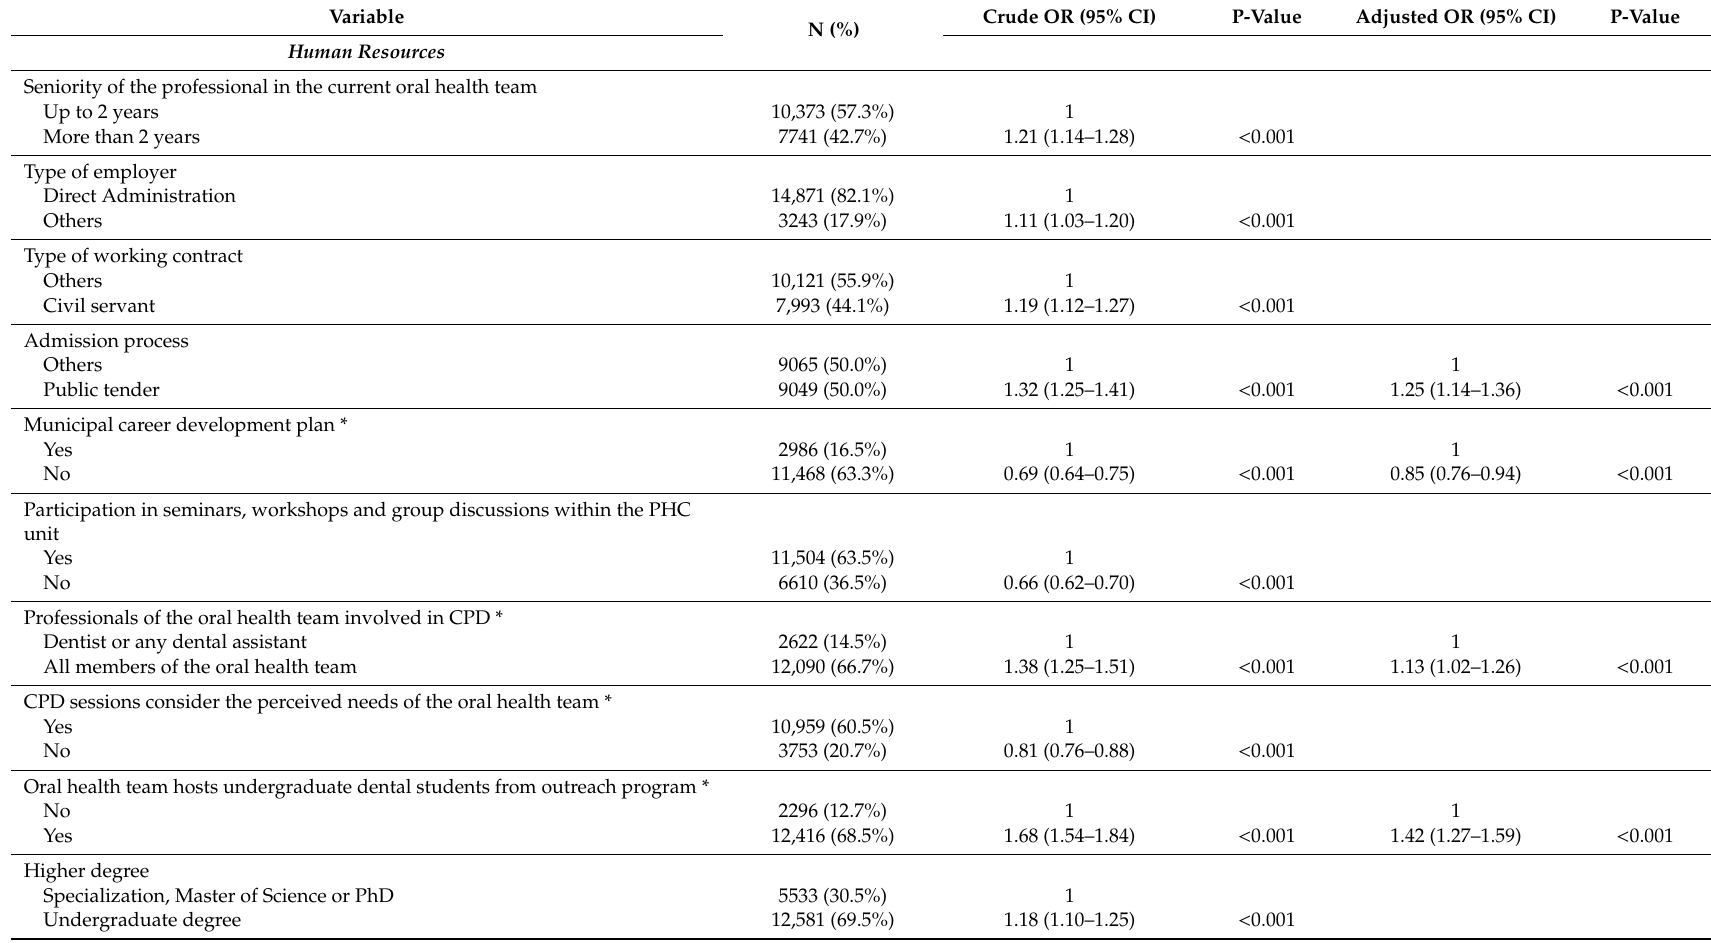
Table 1. Association of human resources and work process variables with provision of dental prostheses in Primary Dental Care in